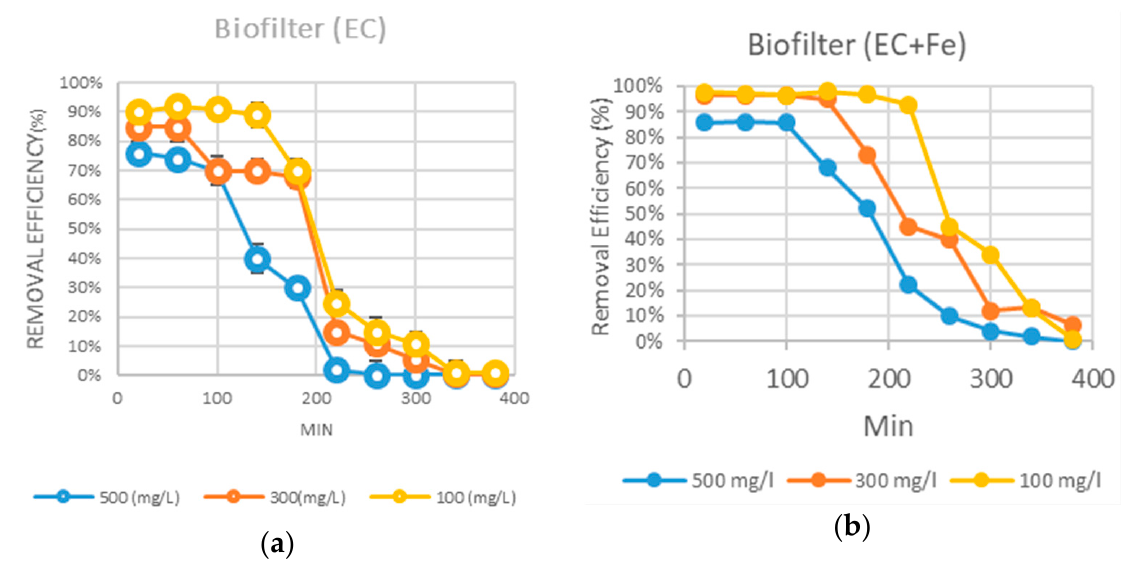
Figure 7. (EC) and (EC + Fe) removal percentages: Biofiliters EC ( a ); Biofilters EC + Fe ( b ).